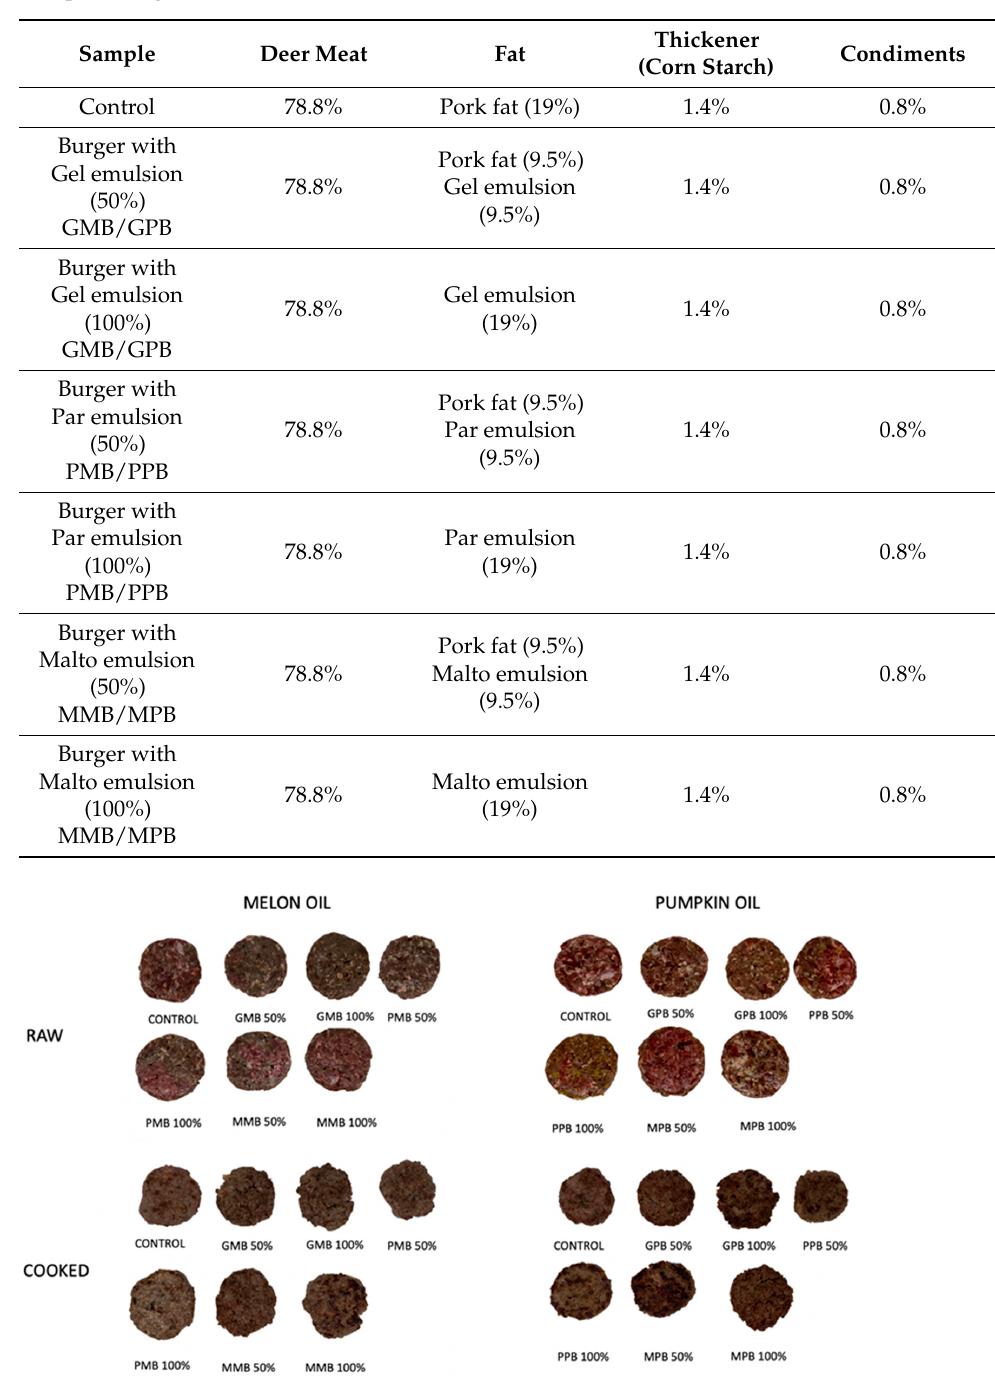
Figure 1. Raw burgers and cooked burgers used for sensory evaluation. Control: Deer meat (78.8%), pork fat (19%), corn-starch (1.4%), spices (0.8%); GMB/GPB 50: Pork fat (9.5%), gel emulsion (9.5%); GMB/GPB 100: Gel emulsion (19%); PMB/PPB 50: Pork fat (9.5%), particle emulsion (9.5%); PMB/PPB 100: Particle emulsion (19%); MMB/MPB 50: Pork fat (9.5%), maltodextrin emulsion (9.5%); MMB/MPB 100: Maltodextrin emulsion (19%). The rest of ingredients in the burgers are the same as the control.